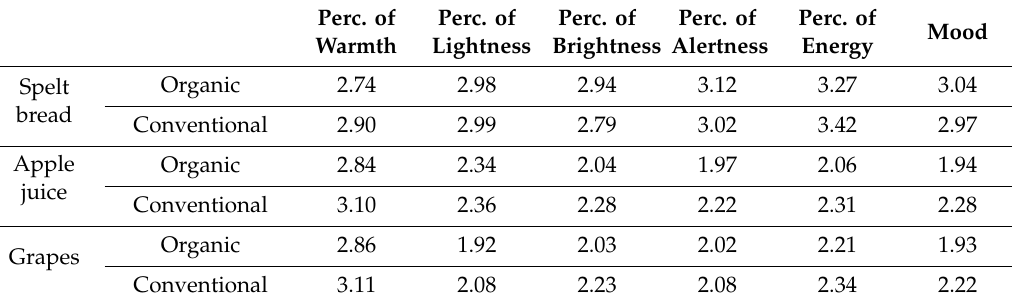
useful, proud. Table 13. Mean values for each criterion of the bipolar scale of 1 (warm, light, bright, alert, energized, good mood) to 5 (cold, heavy, dark, tired, not energized, bad mood) for the three groups of samples (organic and conventional). Perc. stands for perception. Perc.